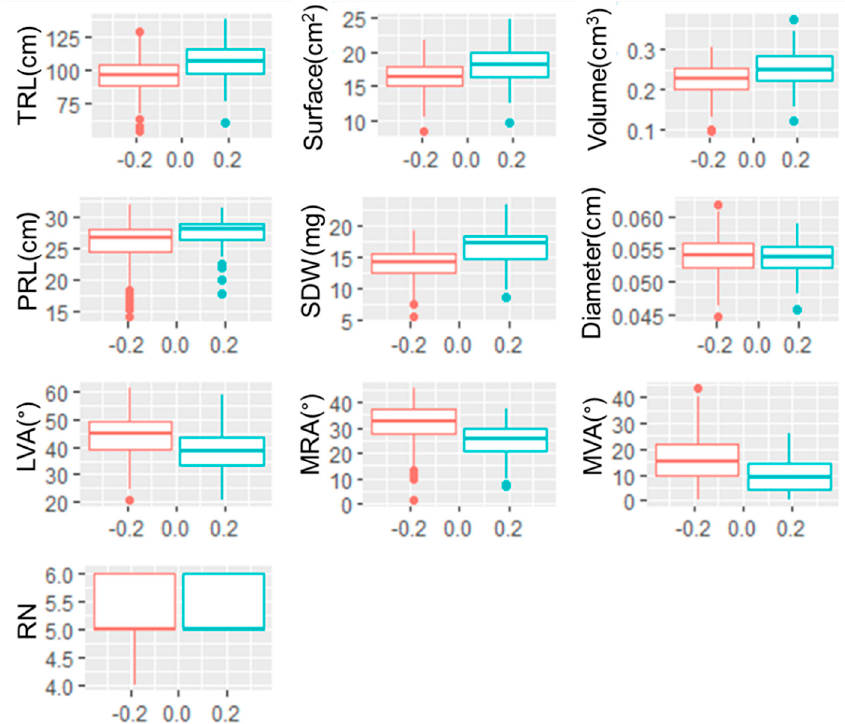
Figure 1. Boxplots for root traits for the cultivar (red) and landrace (blue) groups. Horizontal lines splitting the boxes indicate the median values; box limits indicate the 25th and 75th percentiles; whiskers extend 1.5 times the interquartile range from the 25th and 75th percentiles; outliers are represented by dots. Variable names coded as in Table 2. Genotype mean values are in Table S1.